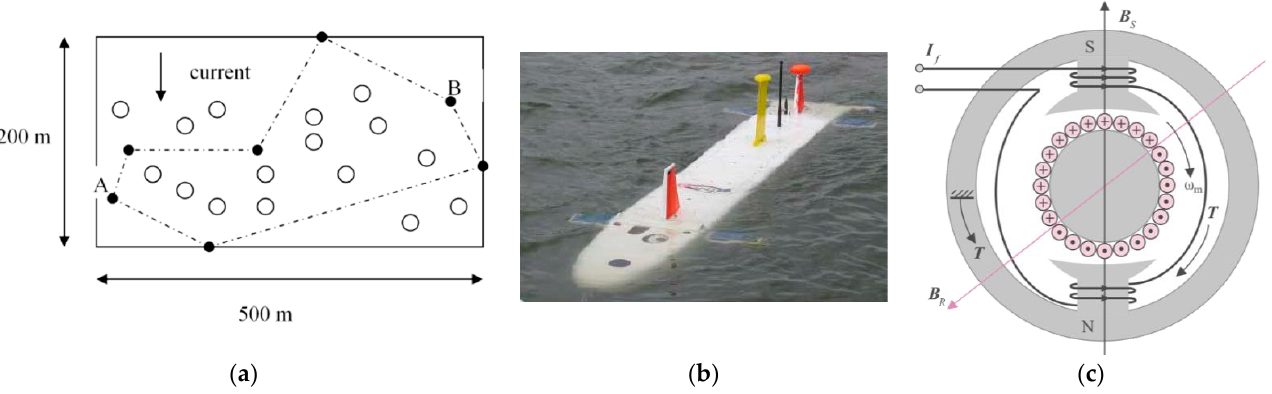
Figure 3. Unmanned underwater vehicles like the Phoenix vehicle in subfigure ( b ) perform dangerous missions like traversing minefields, as depicted in subfigure ( a ). Direct current (DC) motors as diagramed in subfigure ( c ) actuate the control fins to steer the vehicle.